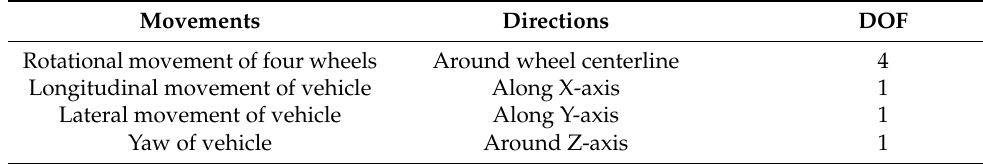
Table 1. DOF Definitions of 7DOF vehicle model. Movements